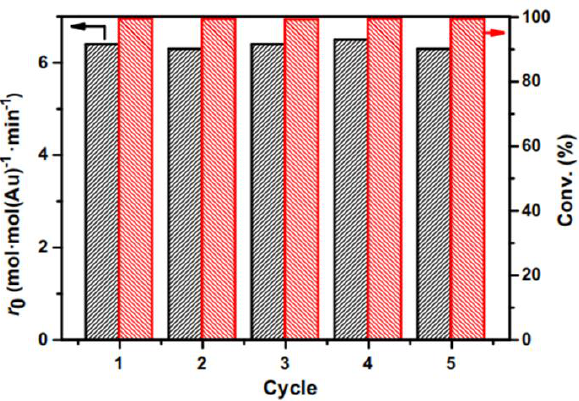
Figure 8. Compilation of the starting reaction rate and product yield for the sequential hydrogenation of 4-NP using the recovered Au/MCN catalyst after 5.5 h. The reaction mixture for each run was 0.36 mmol of 4-NP or 0.32 mmol of p-CNB, 5.08 × 10 −4 mmol of gold, 5.0 mL of ethanol as the solvent at 140 °C, and 4.0 MPa H 2 . Adapted with permission from ref. [29].